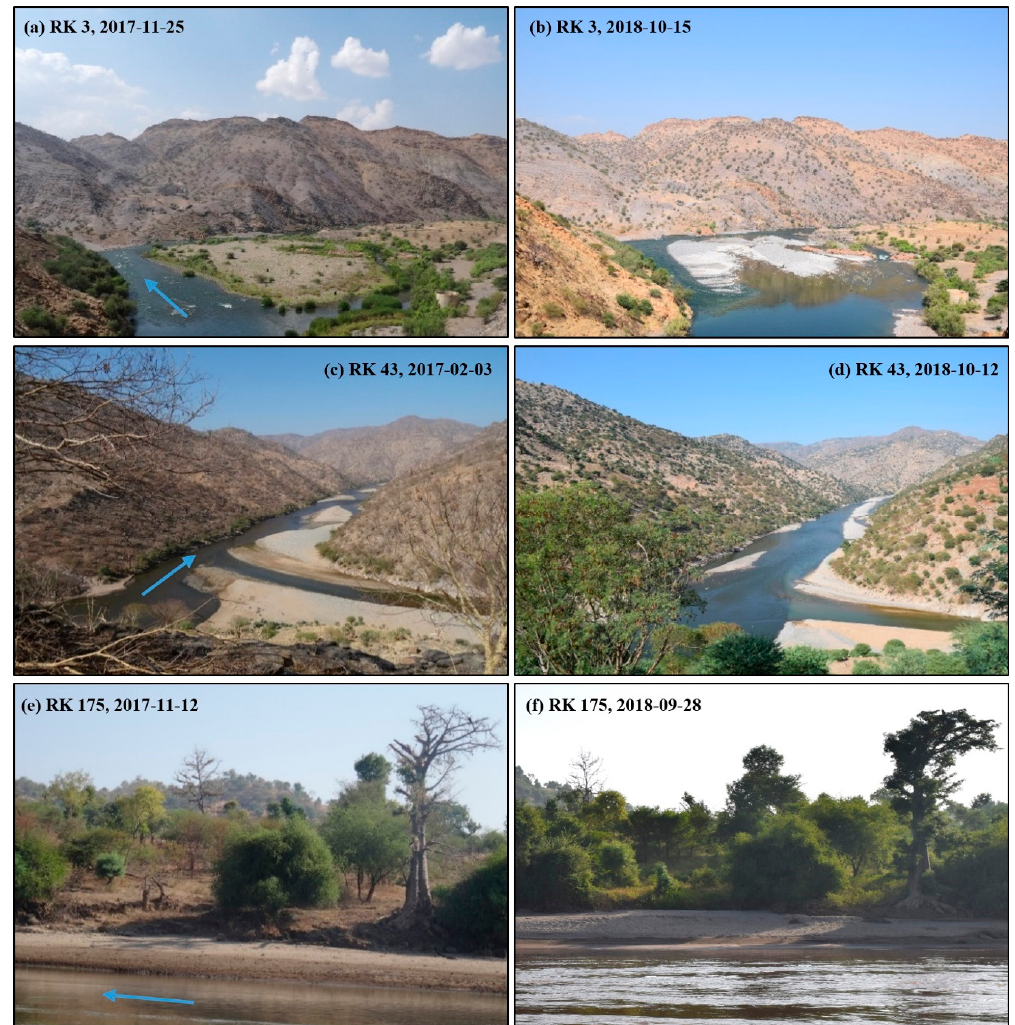
Figure 11. The emergency release from 25 August to 16 September, 2018 induced several hydrogeomorphic changes downstream of the dam: erosion of a 5.4 ha point bar ( a - b ), erosion of the years old alluvial cone of the Weri’i River entering from the right ( c - d ) and thick sandy depositions further downstream ( e - f ).